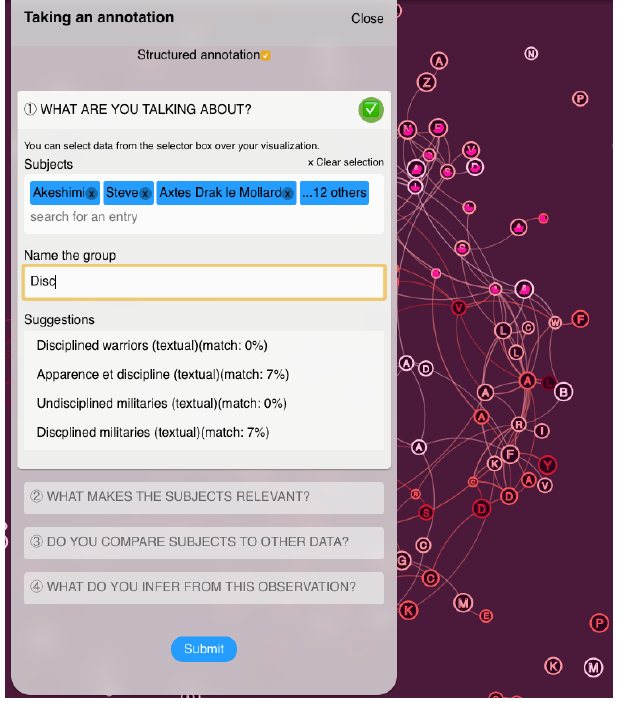
Figure 7. The annotator spots specific characters, names them, and receives suggestions based on the names she is typing.